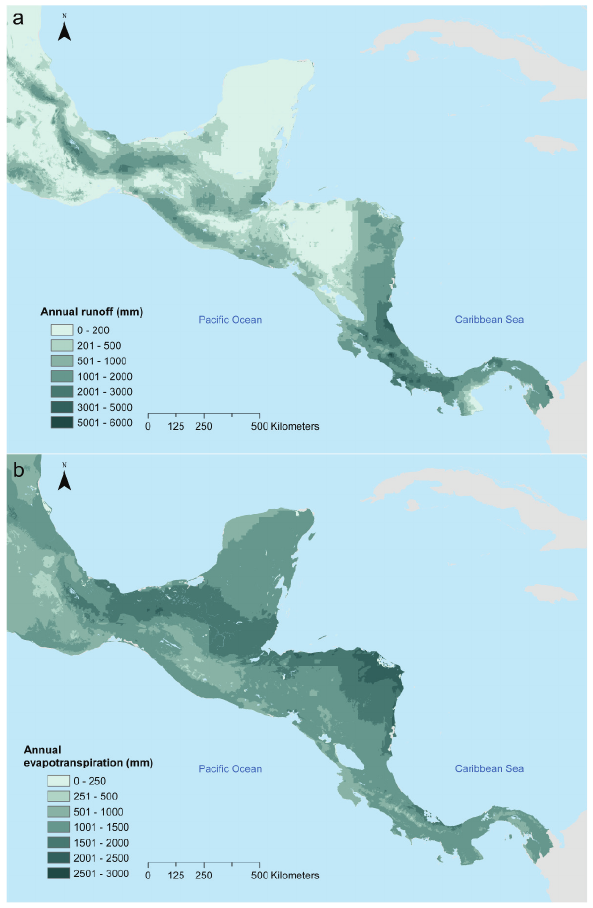
Fig. 9. Annual runoff (a) and evapotranspiration (b) of Mesoamer- ica modelled by MAPSS.